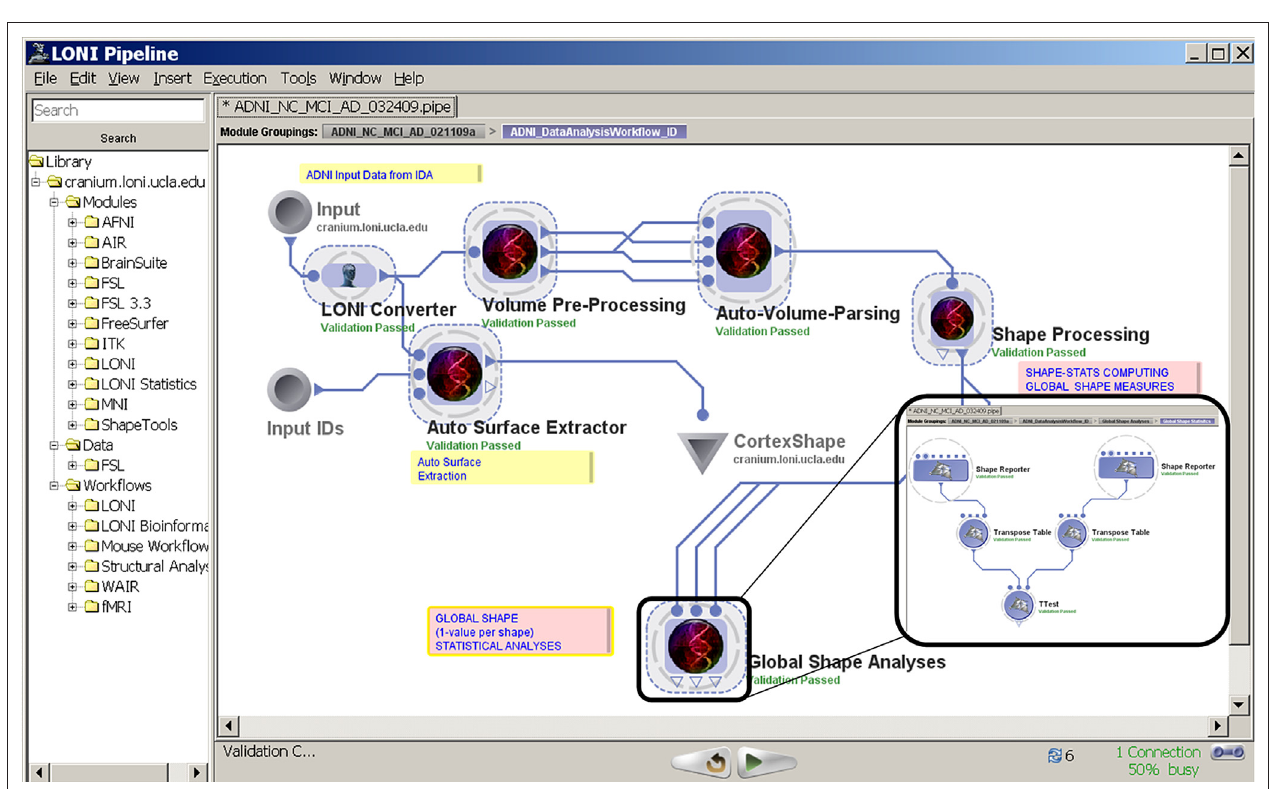
automated cortical surface extraction. Each of these steps is itself a nested collection of modules, a pipeline, which contains a series of processing steps. The insert-fi gure illustrates the 3-level deep nested processing part of the Global Shape Analysis node (see the top-level tabs of the